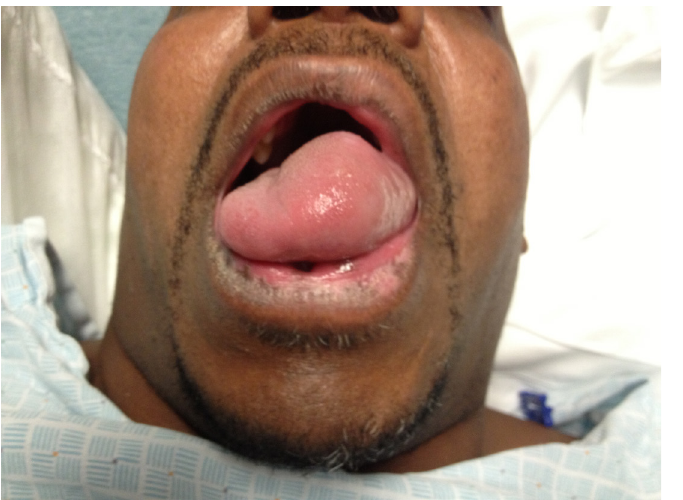
Figure 2 . Patient’s tongue appearance after